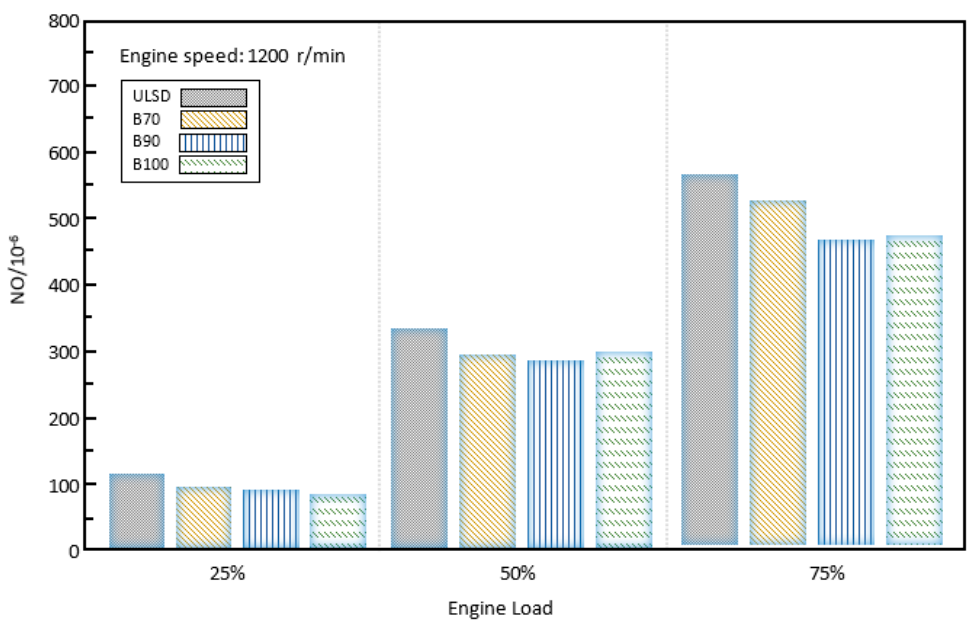
Figure 12. Tested fuels’ influence on the exhaust gas temperature at 1200 rpm.